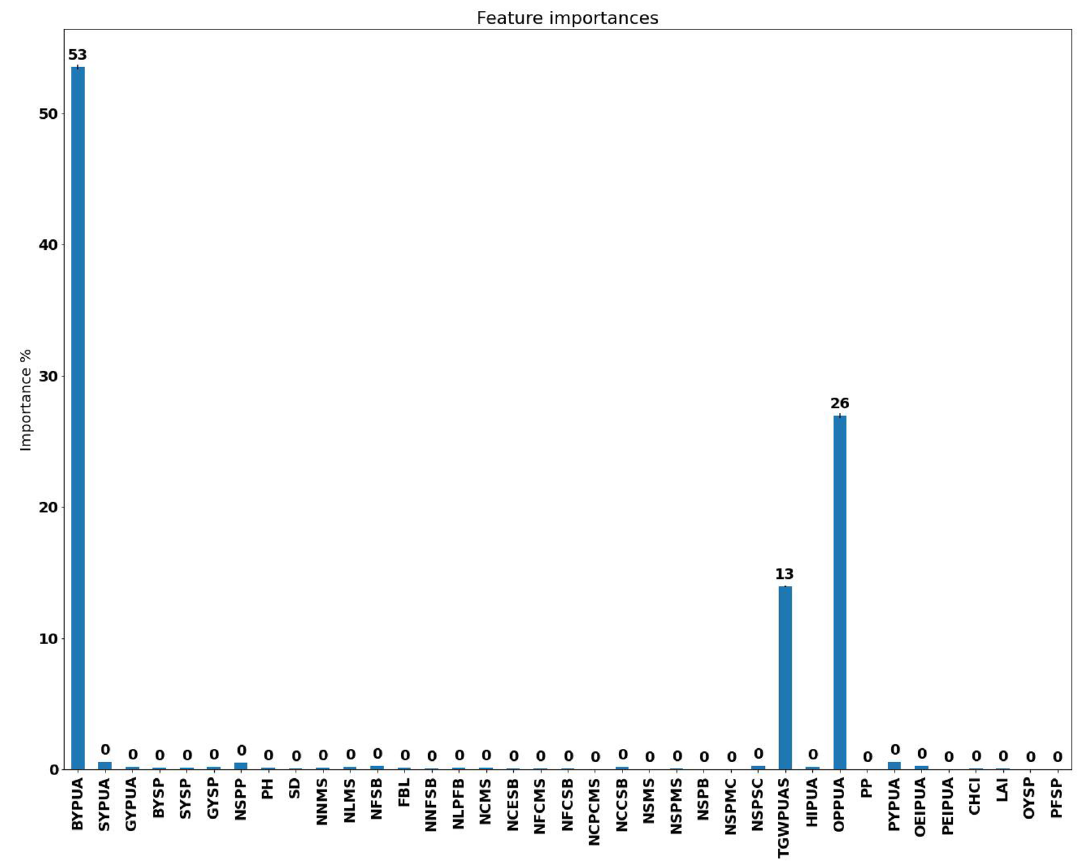
Figure 2. The importance of the traits in the random forest machine learning regression process for the prediction of the grain yield per unit area of the Lallemantia iberica ecotypes. ML